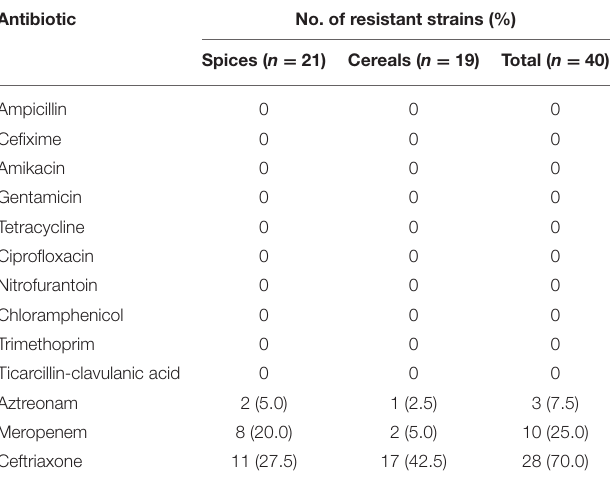
TABLE 4 | Antimicrobial susceptibility of the 40 Cronobacter strains recovered from spices and cereals by agar disc diffusion method.